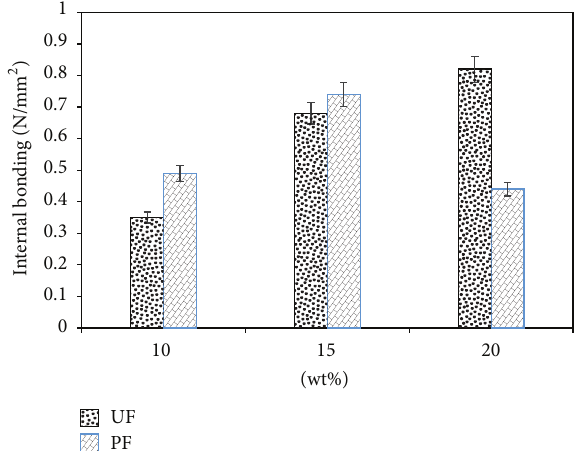
Figure4:Internalbondingofsagoparticleboardversusresinmatrix content